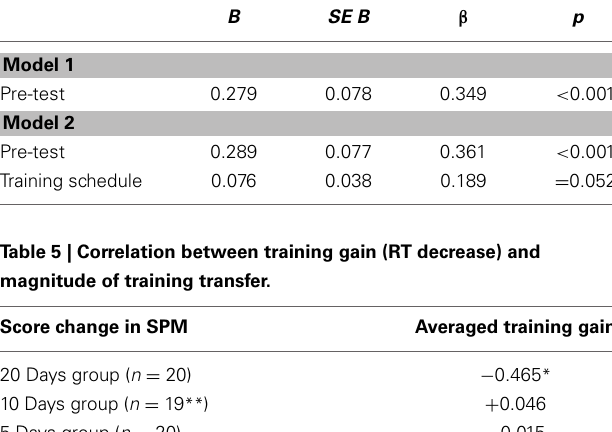
FIGURE 3 | Scores on the SPM before and after training; error bars represent standard error.